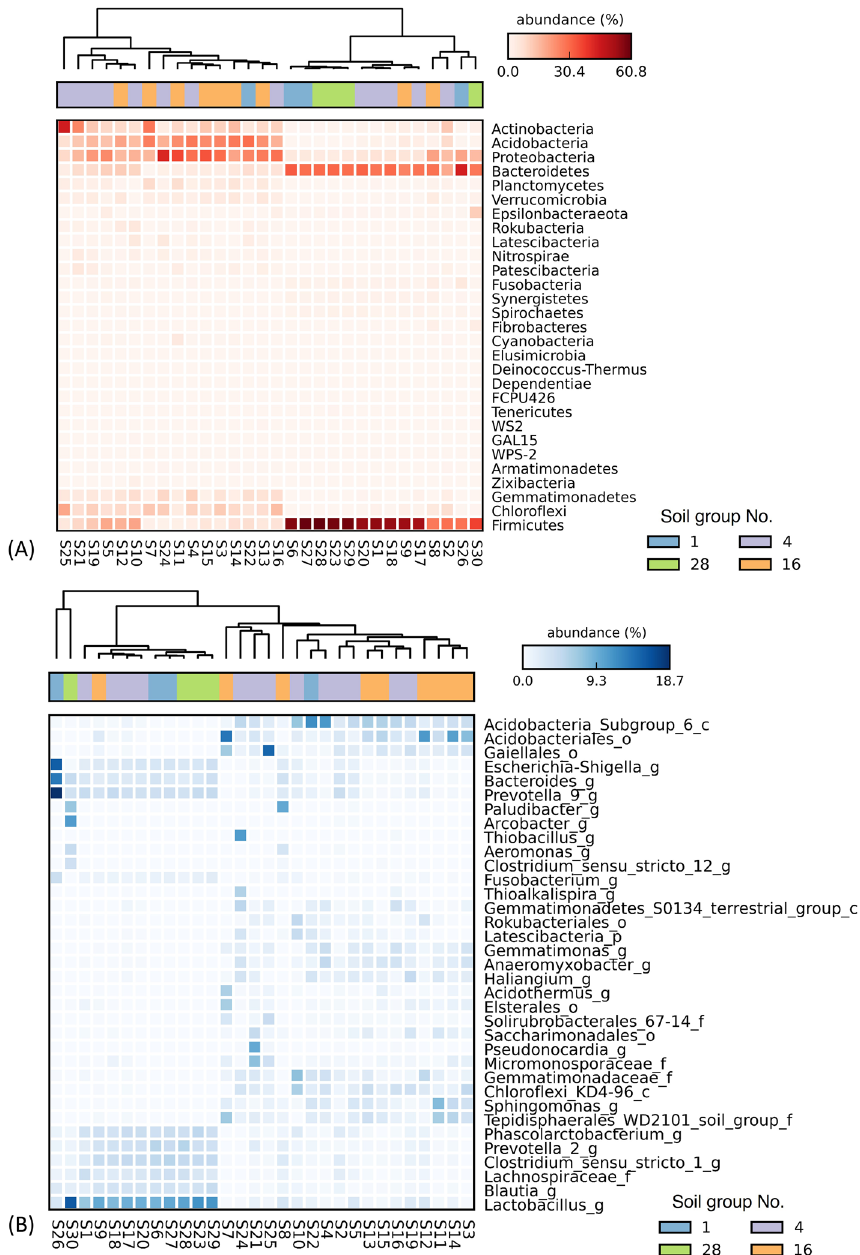
Figure 4. Heat maps of bacterial community compositions at the phylum level ( A , all phyla) and genus level ( B , top 35 genera based on relative abundance). Unknown genera are represented appending family (_f), order (_o), class (_c) and phylum (_p) levels while genus is represented by _g. Each soil group No. is represented in blue (No. 1), purple (No. 4), green (No. 28), and orange (No.